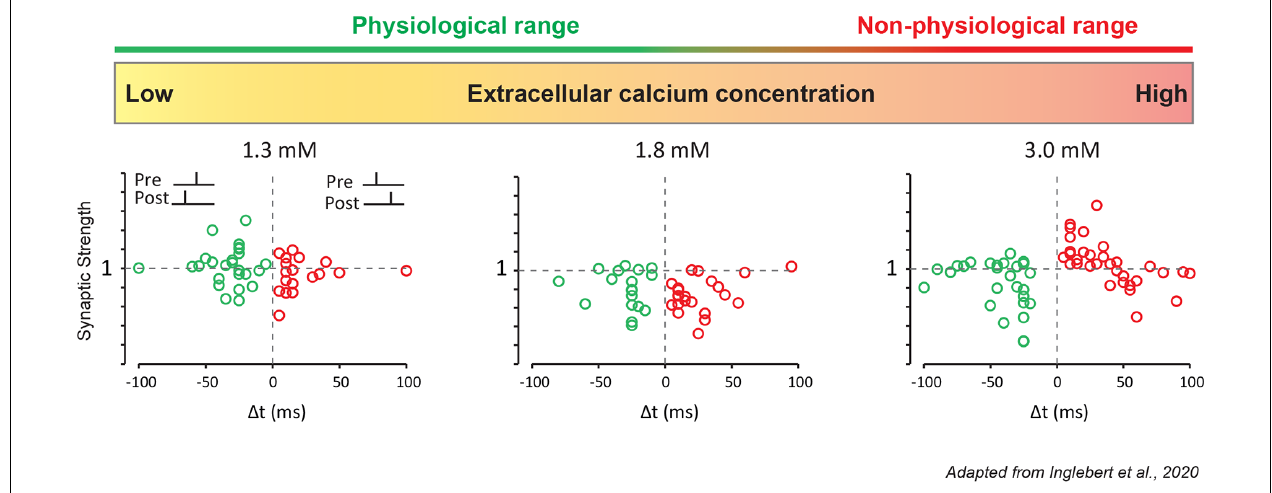
FIGURE 2 | STDP under various external calcium concentrations. CA1 pyramidal neurons were recorded in a whole-cell configuration. Pre-synaptic stimulation was evoked by a stimulation electrode placed in the Schaffer collaterals. These results were obtained with a simple 1:1 protocol (1 presynaptic, 1 postsynaptic stimulation) with a low pairing frequency of 0.3 Hz and 100 repetitions for t-LTP, and 150 repetitions for t-LTD. In 1.3 mM extracellular calcium, no plasticity is induced. In 1.8 mM extracellular calcium, pre-post and post-pre protocols leads to t-LTD. In 3 mM extracellular calcium, pre-post protocol leads to t-LTP and post-pre protocol leads to